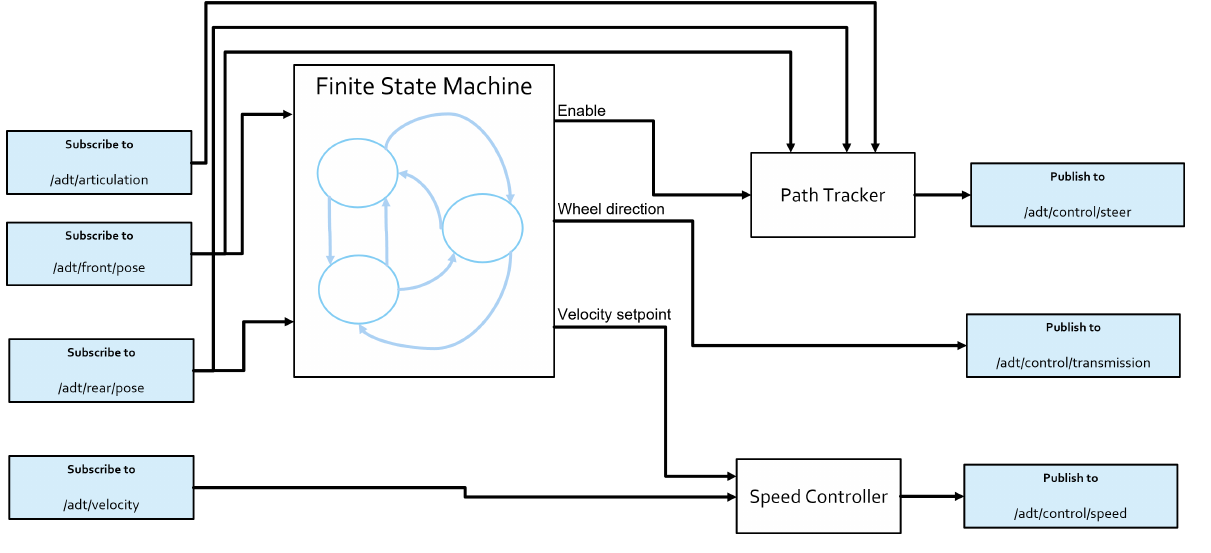
Figure 11. Integration of the FSM and path tracking module in the simulator. The modules sub- scribe to the topics published by the simulated ADT and publish control commands to the control interface